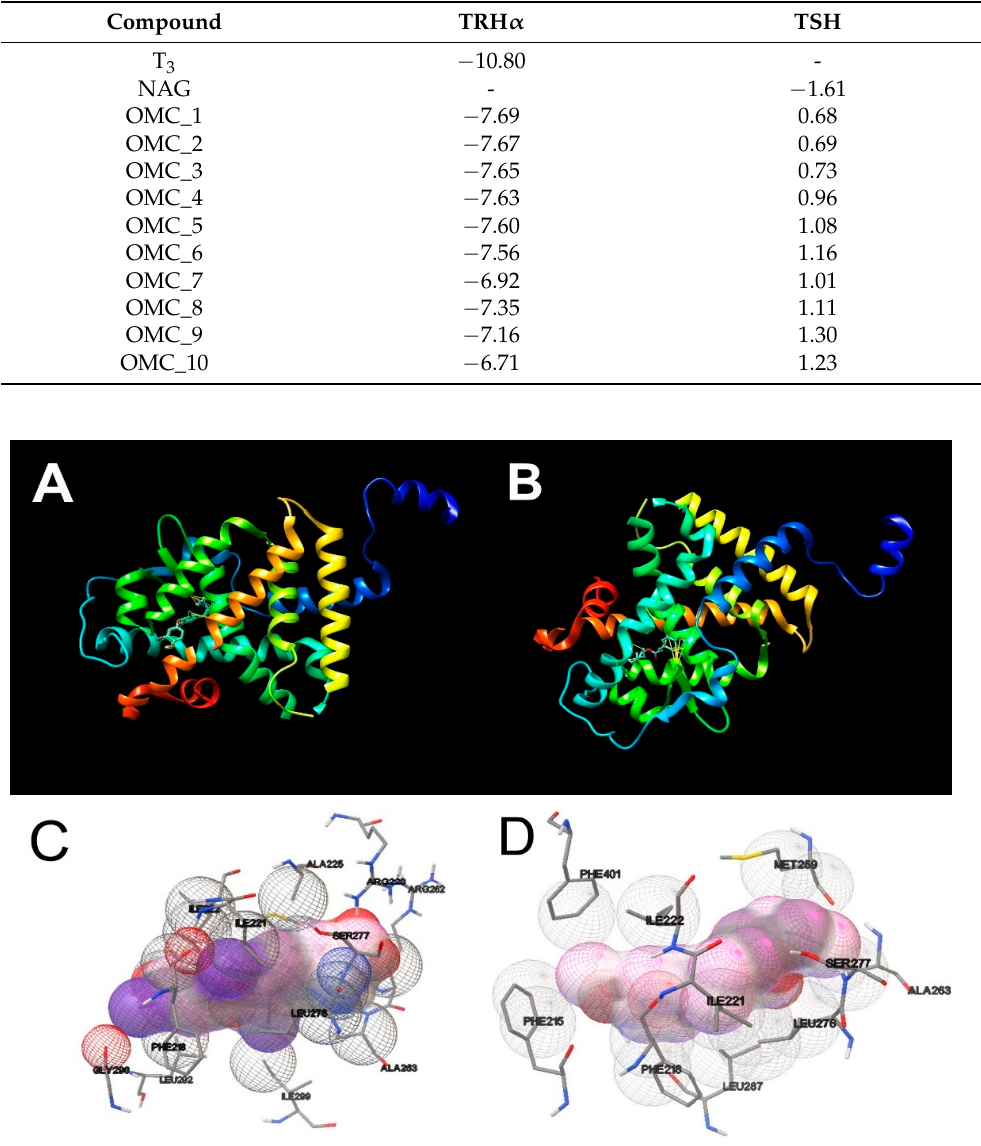
Figure 8. Docking views of the complex between the ligands with THR α using Quimera 1.15 software. ( A , B ) show the 3D representations of the interactions and preferred conformation between natural 3,5,3 ′ Triiodothyronine (T3) and octylmethoxycinnamate (OMC), respectively, within THR α active centre. ( C , D ) show the interactions between natural ligand 3,5,3 ′ Triiodothyronine (T3) and octylmethoxycinnamate (OMC), respectively, to the amino acid residues in the THR α active centre.